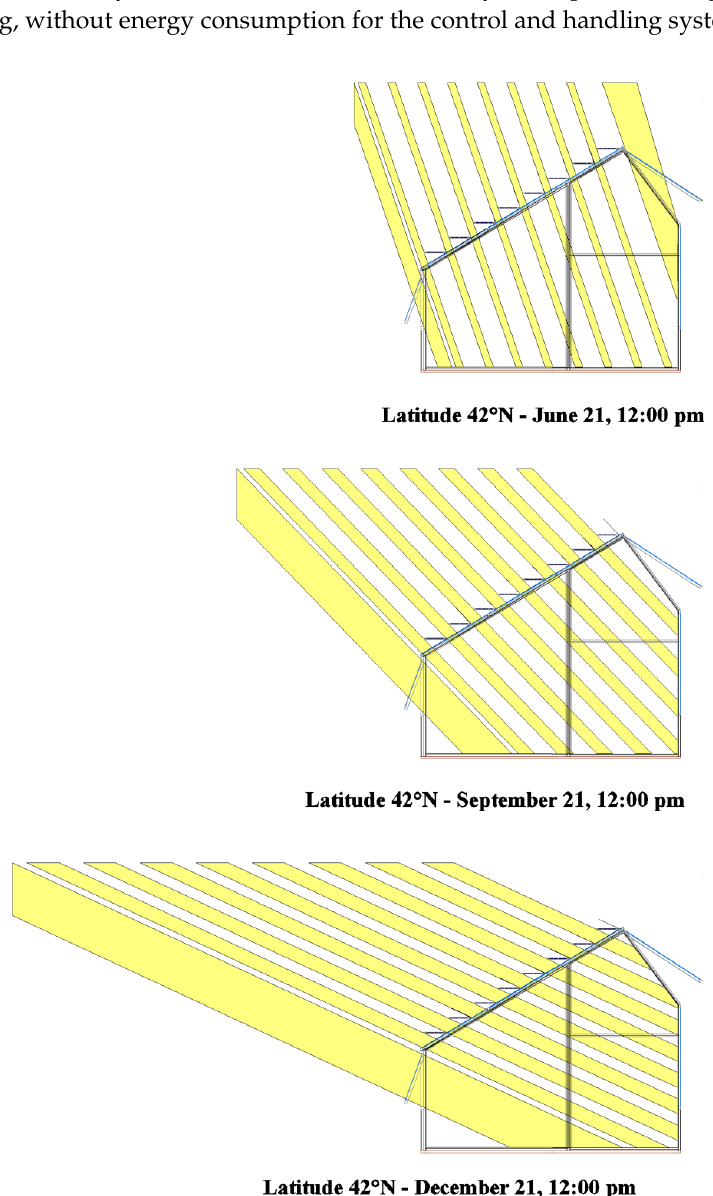
Figure 14. Shading in clear sky conditions with horizontal PV panels. The shading obtained is favorable for crop requirements: maximum in summer, minimum during the